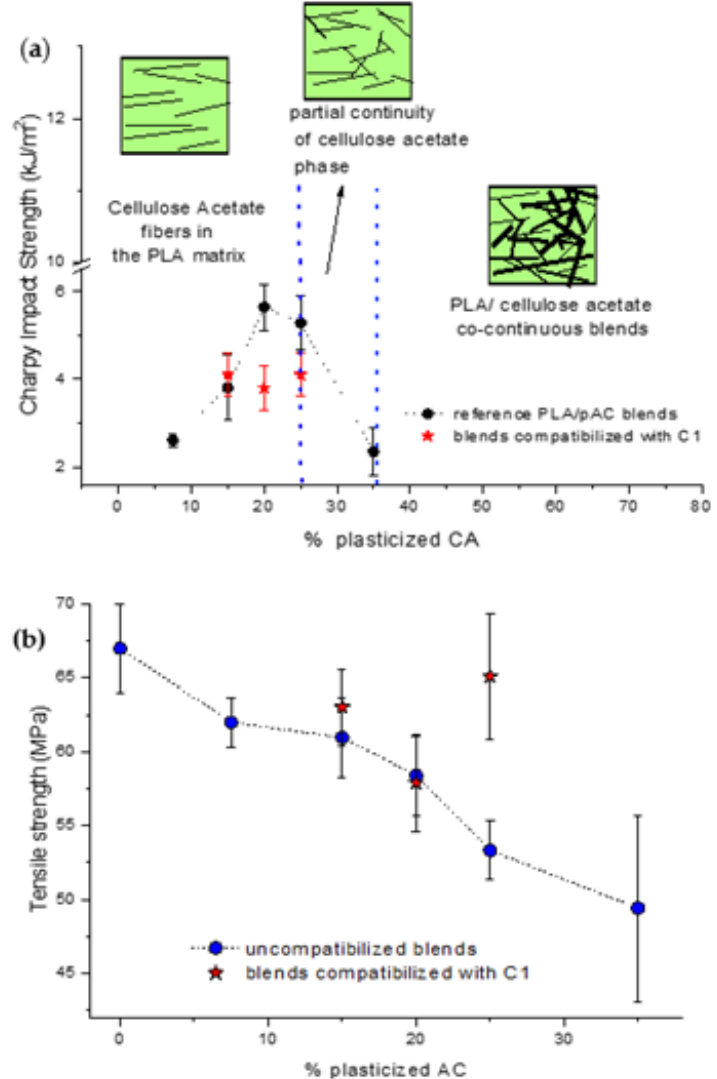
Figure 12. Comparison with the properties of reference blends PLA as a function of pAC content (% by weight). ( a ) Tensile strength; ( b ) Charpy impact strength.